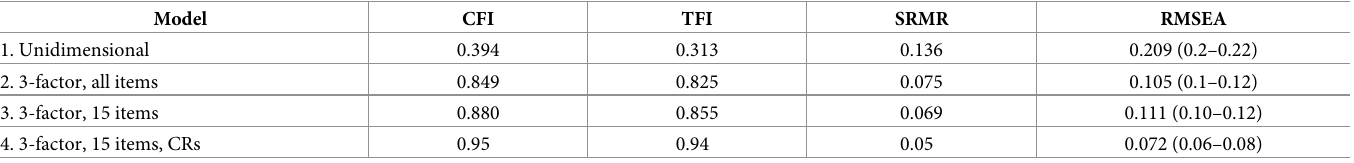
Table 3. Results of confirmatory factor analysis (Study 1; confirmation sample n =